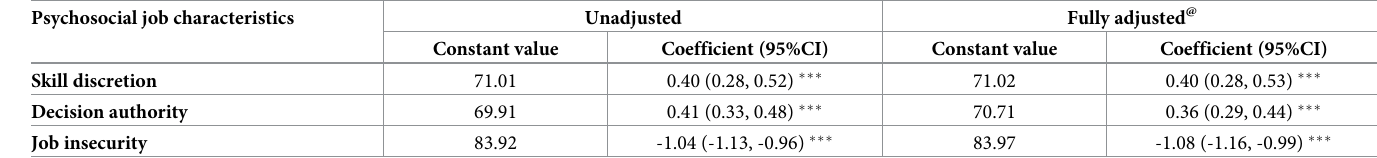
for gender, age and educational attainment either separately (see S2 Table) or simultaneously only caused small changes in the coefficients. The modifying role of migrant status in the relationships between psychosocial job characteristics and mental health Likelihood ratio test results were uniformly null, providing no statistical evidence for any of our three measures of migrant status as effect modifiers of the job characteristic ― mental health relationships (Skill discretion × COB: p = 0.51; skill discretion × dominant language of COB: p = 0.67; skill discretion × years since arrival: p = 0.72; decision authority × COB: p = 0.90; decision authority × dominant language of COB: p = 0.46; decision authority × years since arrival: p = 0.55; job insecurity × COB: p = 0.64; job insecurity × dominant language of COB: p = 0.80; job insecurity × years since arrival: p = 0.70). Table 2. Psychosocial job characteristics and mental health: Unadjusted and adjusted linear regression results (n = 8969). Psychosocial job